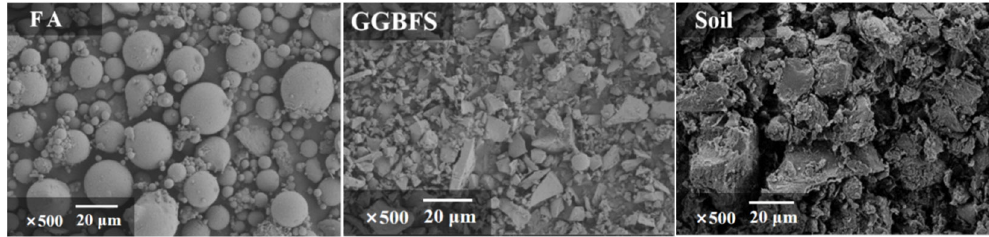
Figure 11. SEM images of the FA, slag (GGBFS), and undisturbed soft soil.